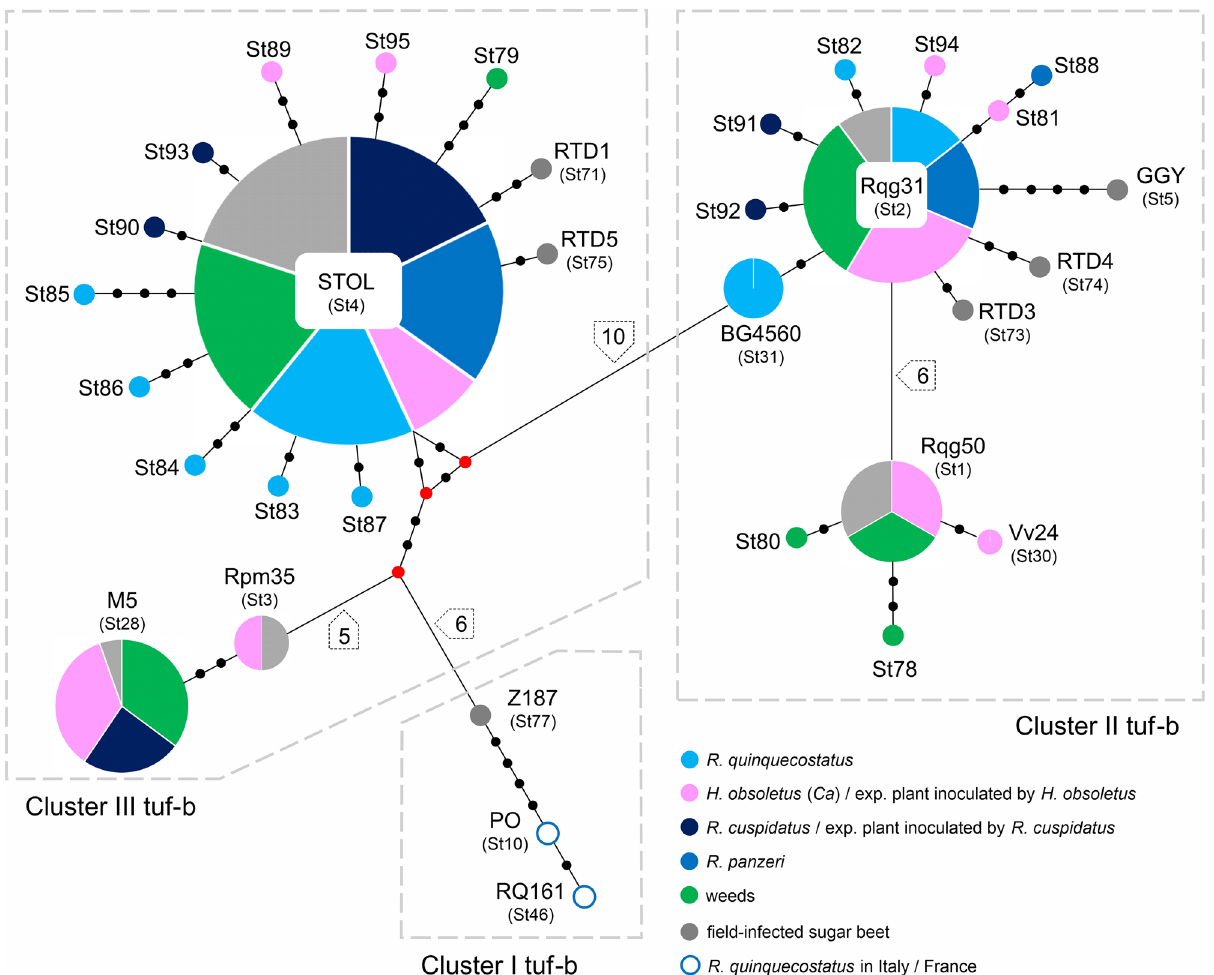
Figure 2. Median-Joining network of CaPsol stamp genotypes involved in RTD of sugar beet associated with tuf-b1 and tuf-d genotypes or with unknown tuf affiliation. Genotypes previously detected in RTD-affected sugar beet, as well as genotypes associated with R. quinquecostatus sensu Holzinger et al. 15 in Italy and France, were included in the analysis 4,16,29 . Circles correspond to a particular CaPsol stamp genotype. Circle sizes are proportional to the genotype frequency and colors correspond to the associated host as described in the legend. The black dots on the connecting lines represent the number of mutations, so as do the numbers noted in pentagons next to the connecting lines. The red dots in the network are median vectors representing missing or unsampled intermediate